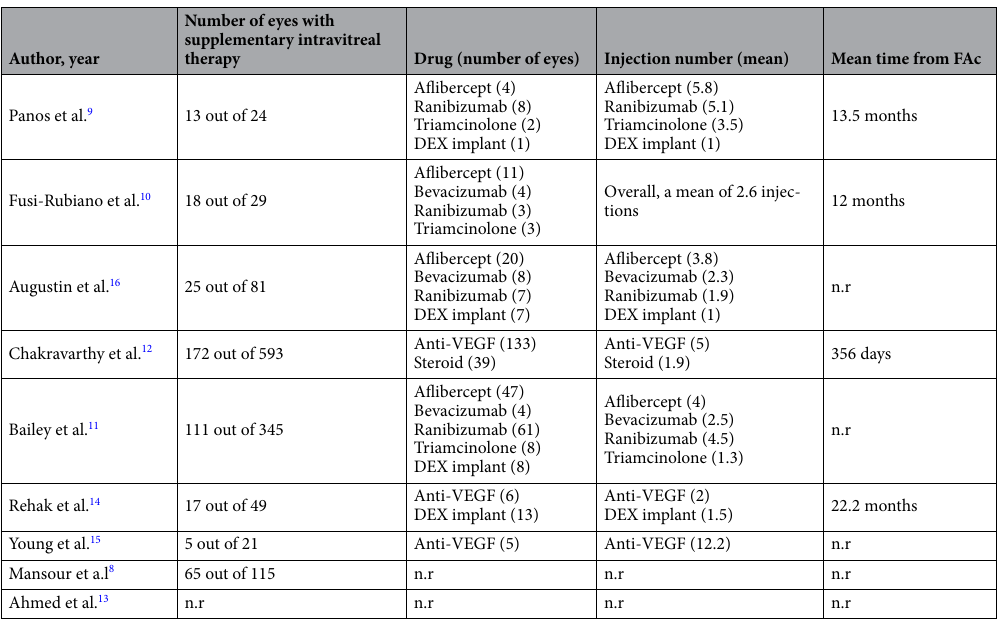
Table 1. Supplementary intravitreal therapy after FAc implant of included studies. FAc fluocinolone acetonide, anti-VEGF anti-Vascular Endothelial Growth Factor, DEX dexamethasone, n.r. not reported.